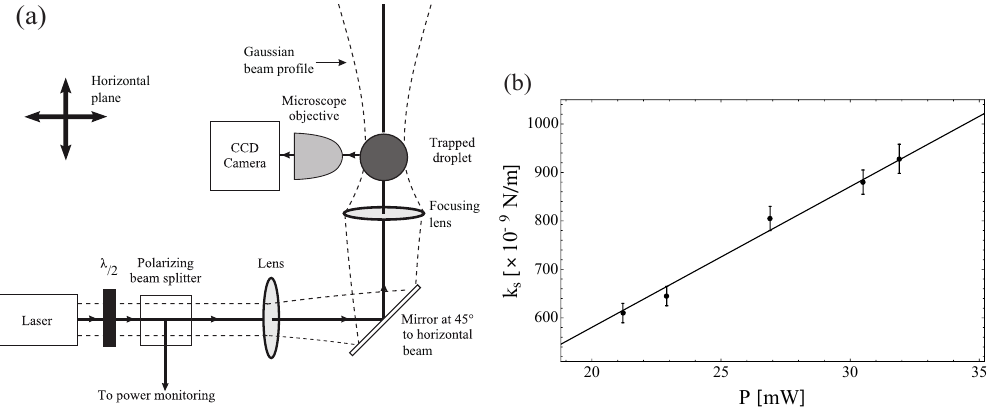
Figure 20. ( a ) Modified experimental set-up for free-space trapping experiment. ( b ) Spring constant of the trap as a function of laser power for a charcoal particle confined in free-space. The horizontal axis has been corrected for the power loss of the microscope